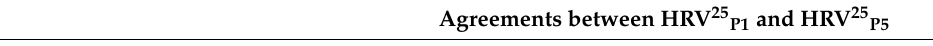
Table 3. Features showing good agreement between 1 min 30 s and 5 min 30 s PPG recordings at 25 Hz.